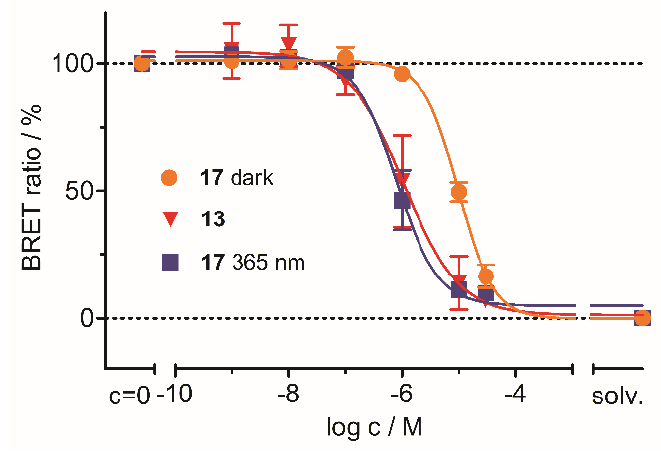
Figure 7. Photocleavage experiments of 17 in the cellular assay setting. Here, 17 365 nm refers to the irradiated sample; 17 dark refers to the data collected without irradiation. Inhibitor 13 (uncaged analog of 17 ) served as the reference compound.